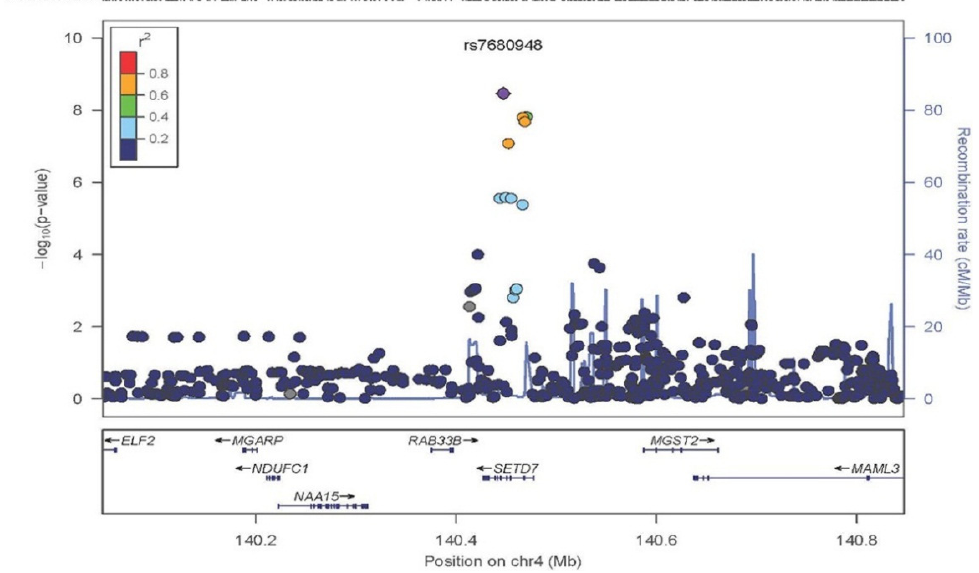
Figure 2. Regional association plot of chromosome 4q31.1 in the area of SETD7 . Variant rs7680948 provides genome-wide significant evidence of association with serum lycopene concentrations. The x-axis represents chromosomal position on chromosome 4 with the location of genes at the locus annotated. The left y-axis shows the p -value for association tests at each locus (dot) on the log scale. The right y-axis provides recombination rates in centimorgans per megabase in the chromosomal region identifying recombination hotspots in the region (grey line). The diamond is the “top hit” ( i.e. , the strongest association). Other SNPs in the region are represented by circles. The colors indicate linkage disequilibrium per the r 2 map on top left. Linkage disequilibrium associated with the top signal appears to span the entire region of gene SETD7